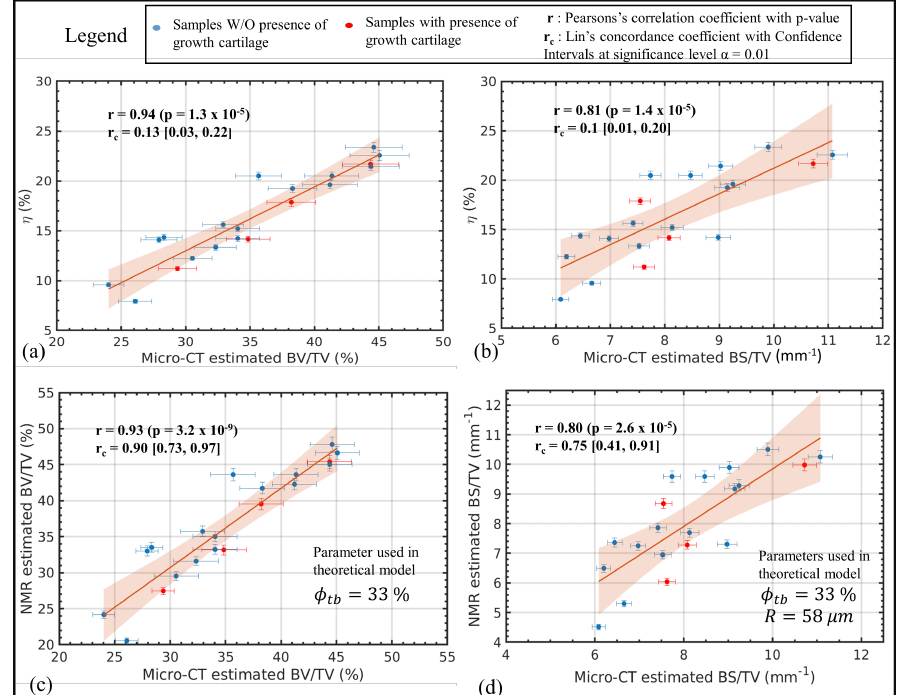
Figure 7. ( toprow ) Plots of η , the short T 2 intensity fraction, evaluated using the quasi-continuous T 2 distributions, against the structural parameters evaluated by the micro-CT analyses. ( a ) the BV/TV; ( b ) the BS/TV ( bottom row ) Comparison between NMR and micro-CT estimated structural parameters; ( c ) BV/TV; ( d ) BS/TV. The average intra-trabecular porosity φ tb = 33%, measured experimentally, was used in the theoretical models to estimate BV/TV and BS/TV with NMR. For the BS/TV, the trabeculae were modeled as cylinders and the the average radius R = 58 µ m, estimated from average trabecular thickness measured with micro-CT, was used. The figure was modified from reference [50]. Copyright (2020) Wiley. Used with permission from reference